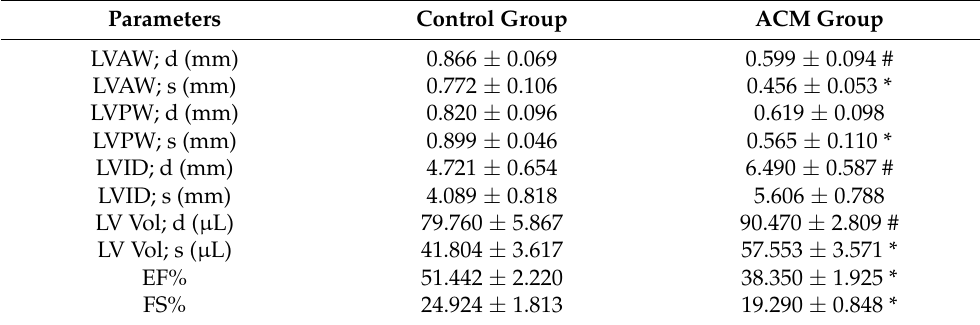
Table 1. The results of echocardiography. Parameters Control Group ACM Group LVAW; d